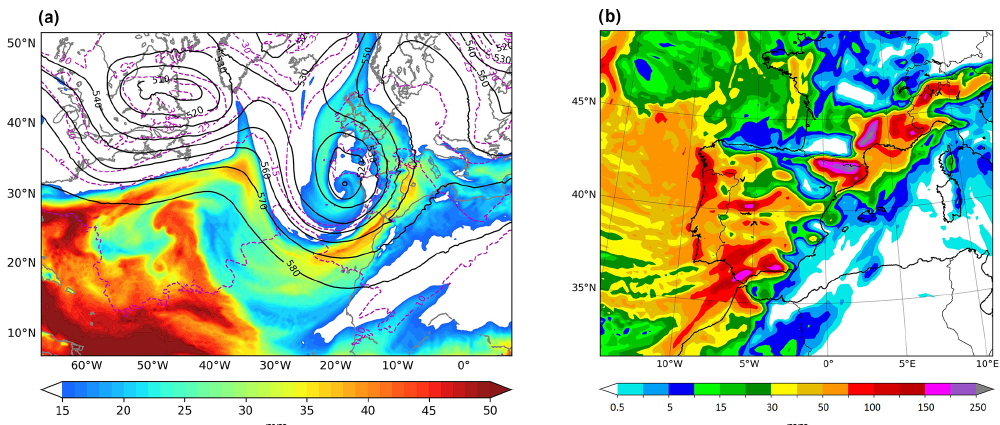
Figure 5. (a) Synoptic situation (from WRF simulation) on 7 November 1982 at 12:00UTC. Geopotential height (solid black contours, dam) and temperature at 500hPa and total precipitable water (shades,mm). (b) Simulated total precipitation (mm) from 6 November at 06:00UTC to 9 November at 06:00UTC (Insua-Costa et al., 2019).